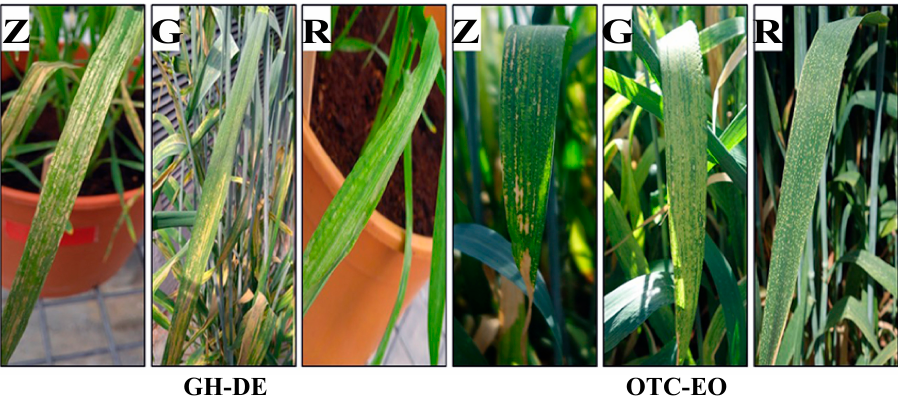
Figure 4. Foliar injury. Symptoms of O 3 -induced foliar injury on the flag leaves of ‘Zahir’ (Z), ‘Gedera’ (G), and ‘Ruta’ (R) in the GH (GH-DE) and the field (OTC-EO) at elevated O 3 exposure.